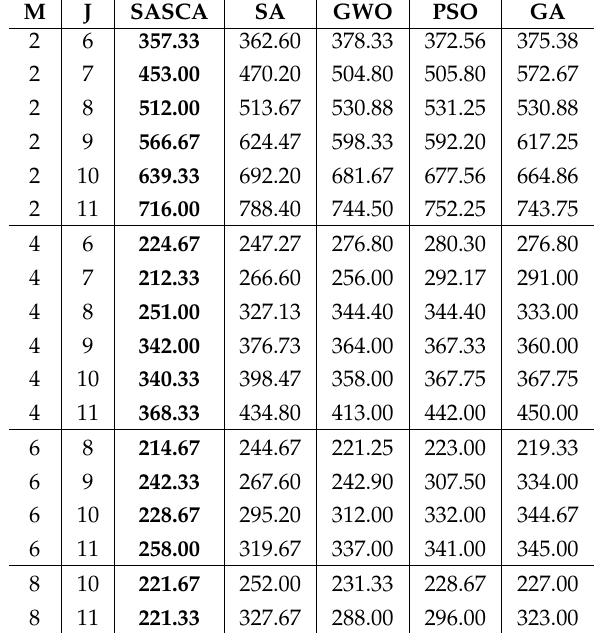
Table 2. Average of C max values of the small problems for each algorithm (best results are in boldface).